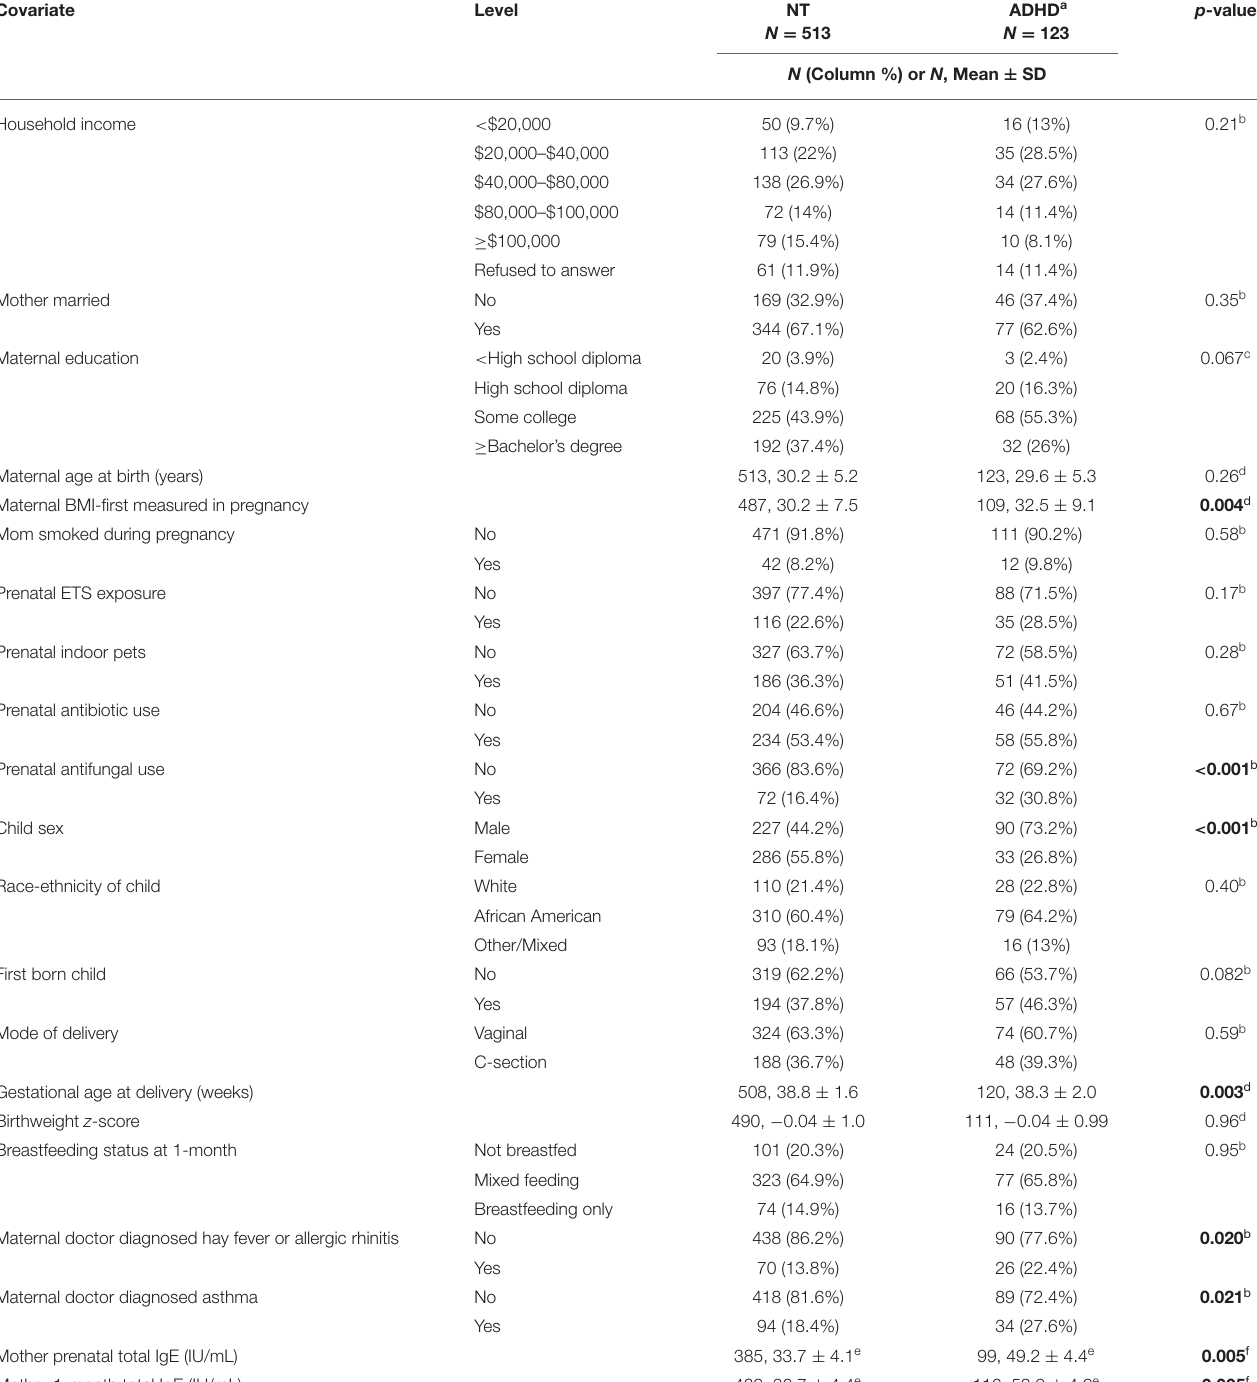
TABLE 2 | Maternal and child characteristics associated with ADHD ( N = 636).